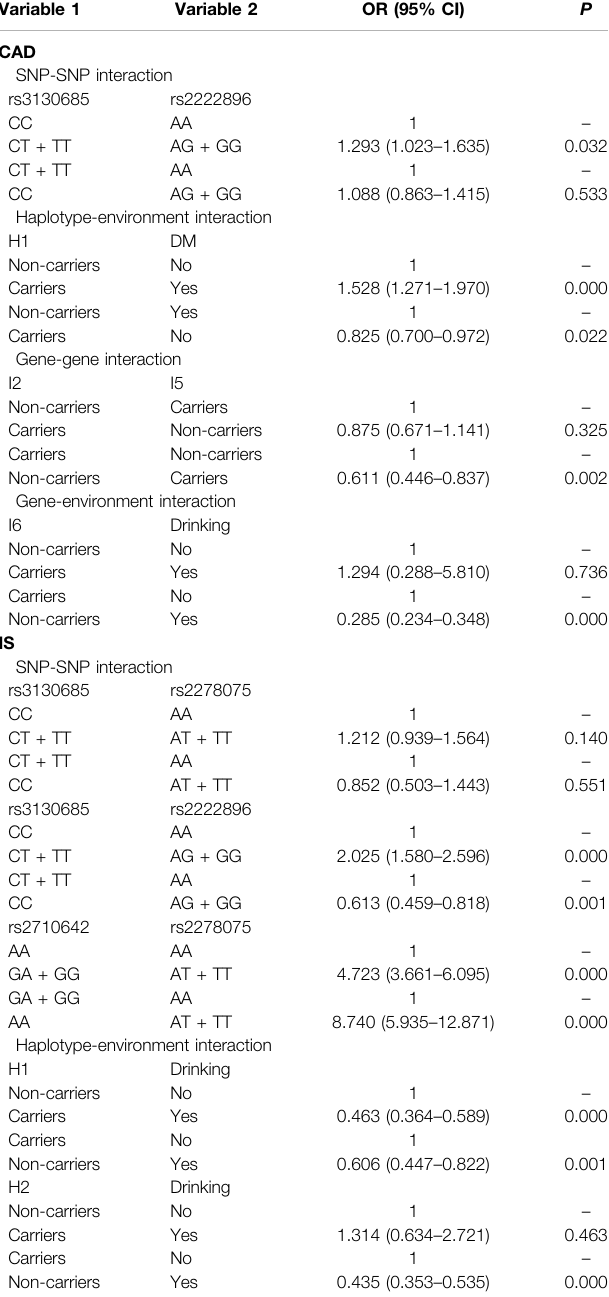
TABLE 9 | Risk of CAD or IS with different types of